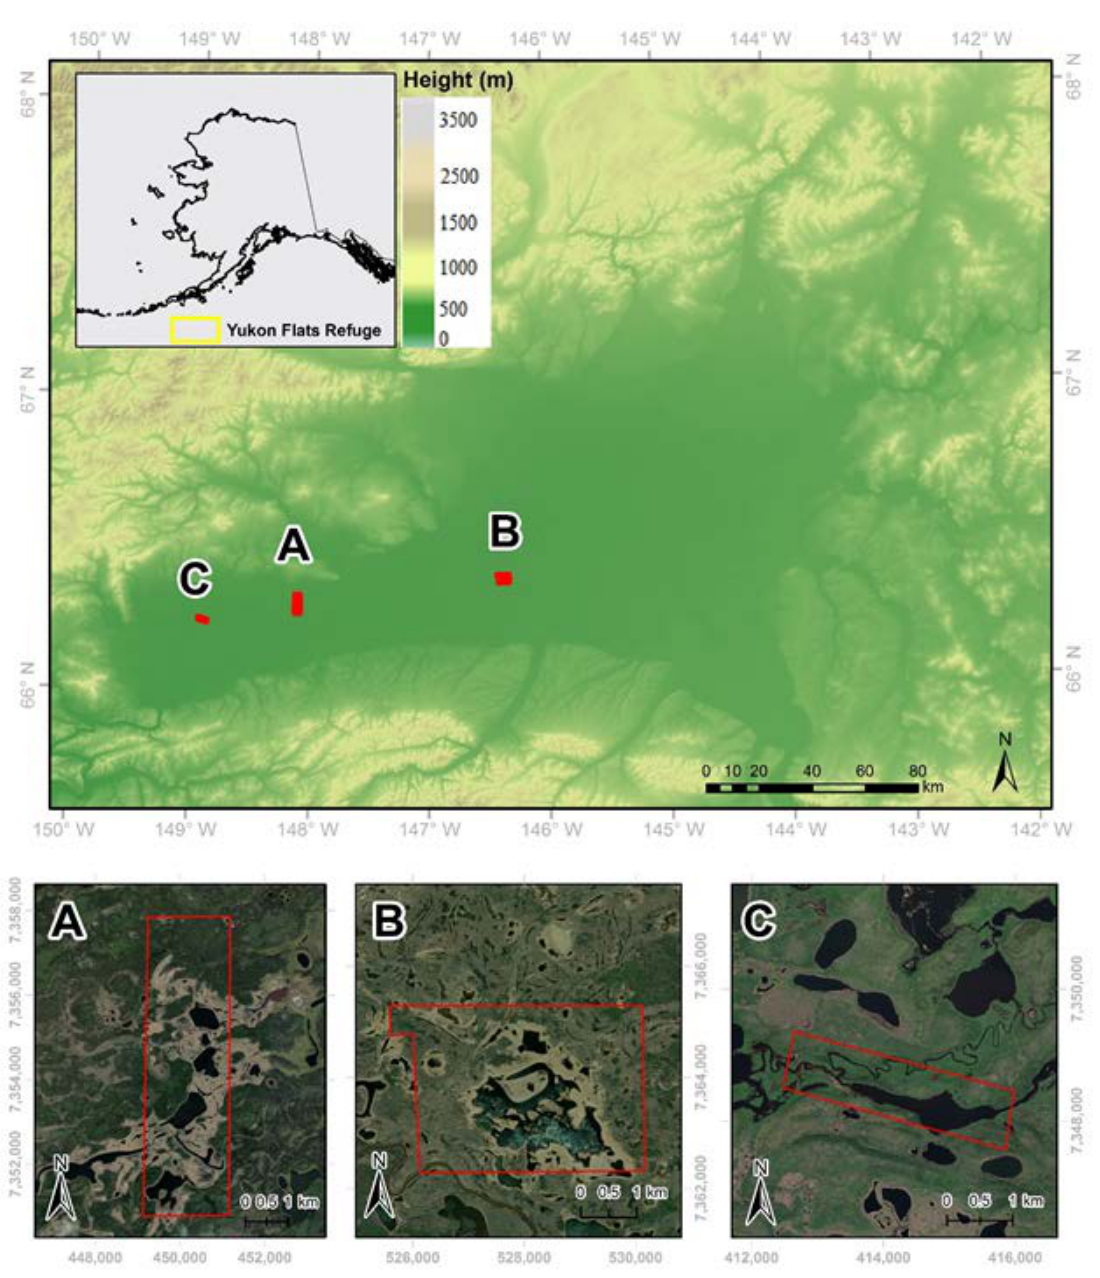
Figure 1. Map of the Yukon Flats National Wildlife Refuge, Alaska, showing flight areas labeled A, B, and C. Upper panel in geographic projection system and lower panels in UTM-6N projection system. All panels are in datum